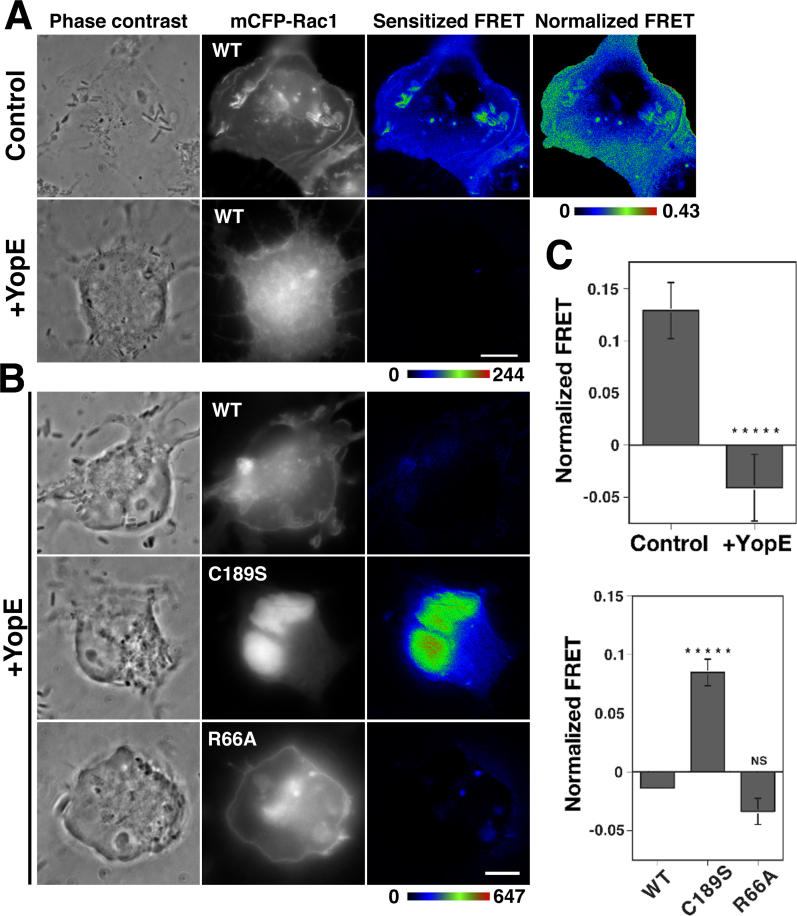
YopE Selectively Inactivates Membrane-Associated Rac1.COS1 cells cotransfected with plasmids expressing mYFP-PBD and noted plasmids were challenged at 37 °C for 30 min with Y. pseudotuberculosis YP17(yopH −, yopT −, yopE −) (noted as “Control” in [A] and [B]) or YP17/pYopE (noted as “+YopE” in [A–C]). Bacteria were grown at 37 °C for 1 h to induce expression of the type III secretion system prior to infection (Materials and Methods). The C189S mutation blocks plasma membrane localization of Rac1, whereas R66A prevents extraction of Rac1 by RhoGDI from plasma membrane into cytosol.(A and B) Displayed are images of typical cells showing phase contrast, mCFP fluorescence and color-scaled sensitized FRET or normalized (Rac1 activation) for YP17 (A) or Yp17/pYopE (A and B) infected cells (Materials and Methods). White bar represents 10 μm.(C) Cytoplasmic Rac1 is not a YopE target. Normalized FRET was determined (Materials and Methods) by imaging cytoplasm of eight infected cells (Materials and Methods). Data for mCFP-Rac1 activation was normalized against mCFP-Rac1 intensity (normalized Rac1 activation) and displayed as mean ± SEM. *****, p < 5 × 10−6 between control cells and YopE-treated cells or between Rac1(WT) and Rac1C189S-transfected cells. NS, no significant difference between Rac1(WT)-transfected cells and Rac1R66A-transfected cells.